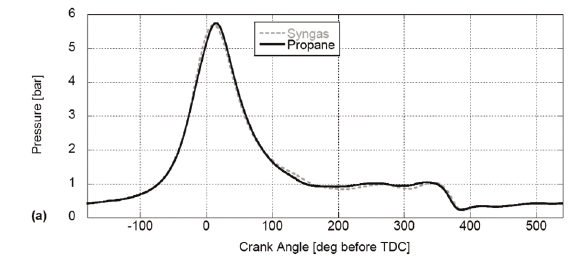
Fig. 3. Pressure course in the combustion chamber as a function of the angle of rotation of the crankshaft for "No Load" [13]